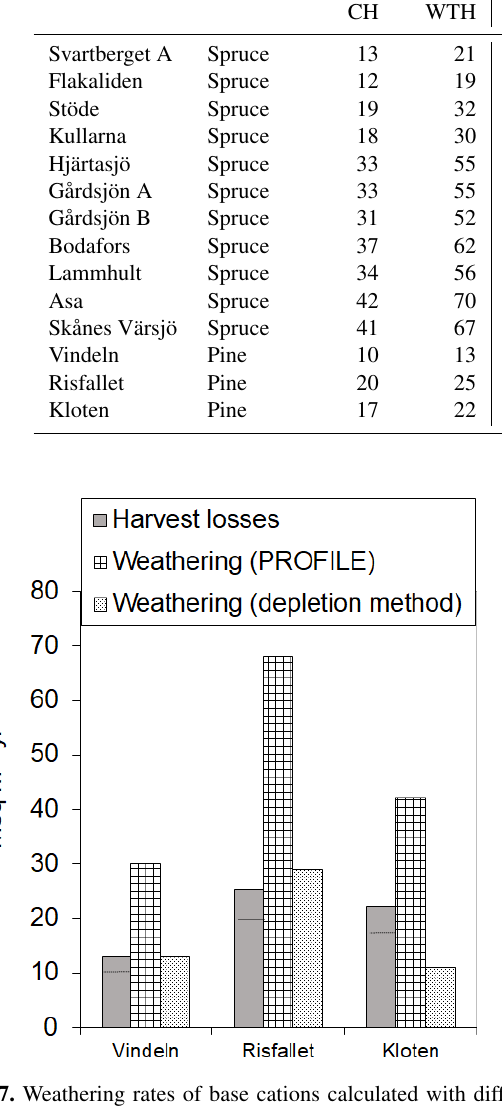
Figure 7. Weathering rates of base cations calculated with differ- ent methods on pine sites, compared with harvest losses of base cations at whole-tree harvesting (100% of the stems and 60% of the branches harvested, and 75% of the needles on the branches re- moved). The horizontal dashed lines in the harvesting bars show the levels for stem-only harvesting. The sites are ordered from north to